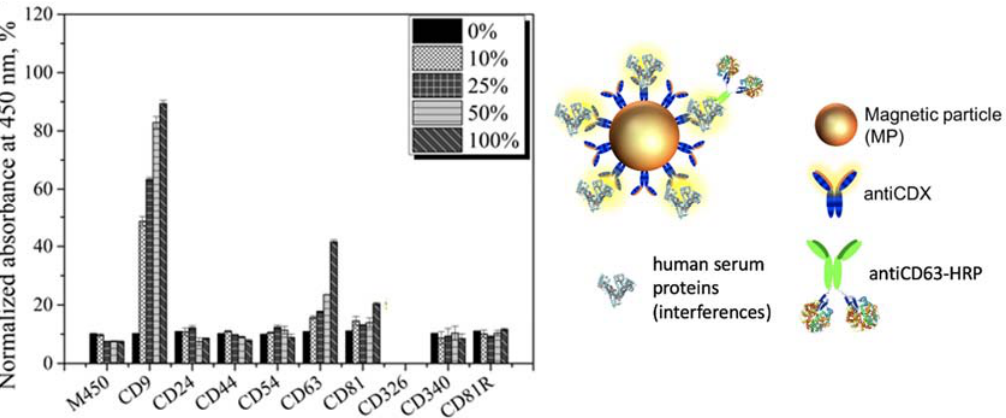
Figure 9. Evaluation of the matrix e ff ect in exosome-depleted human serum using antiCDX-MPs modified with antibodies against CD9, CD24, CD44, CD54, CD63, CD81, CD340 and CD81R (rabbit polyclonal) biomarkers for the IMS, followed by direct labeling with an antiCD63-HRP antibody (1.24 µ g mL − 1 ) in depleted human serum. In this instance, no exosomes were spiked in the samples. All other conditions are as in Figure 8. The error bars show the standard deviation for n =